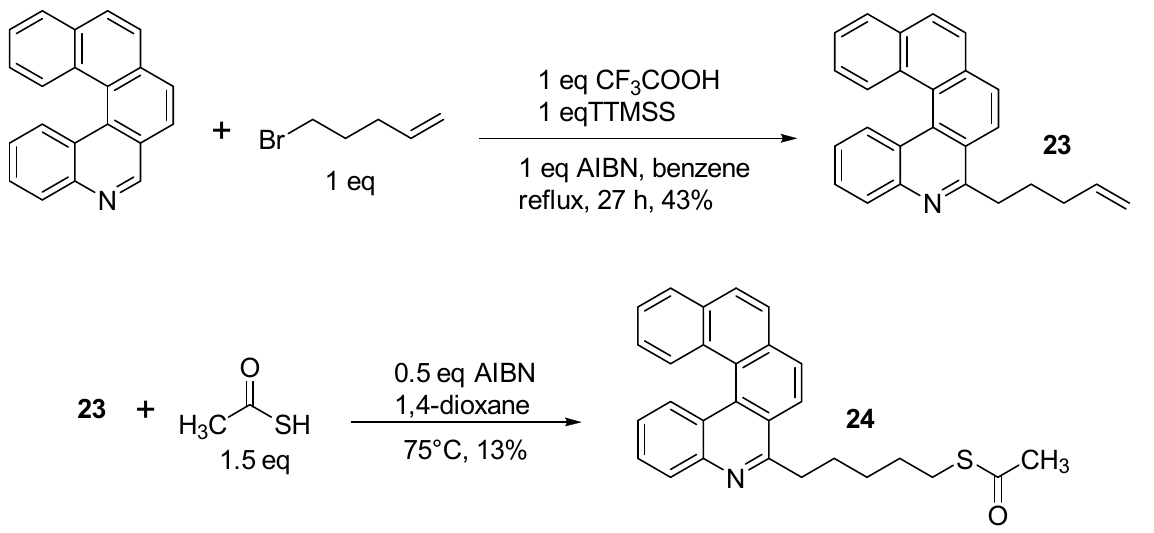
Scheme 22. The formation of S-[5-(6-(5-aza[5]helicenyl)pentyl] ethanethioate 24 .